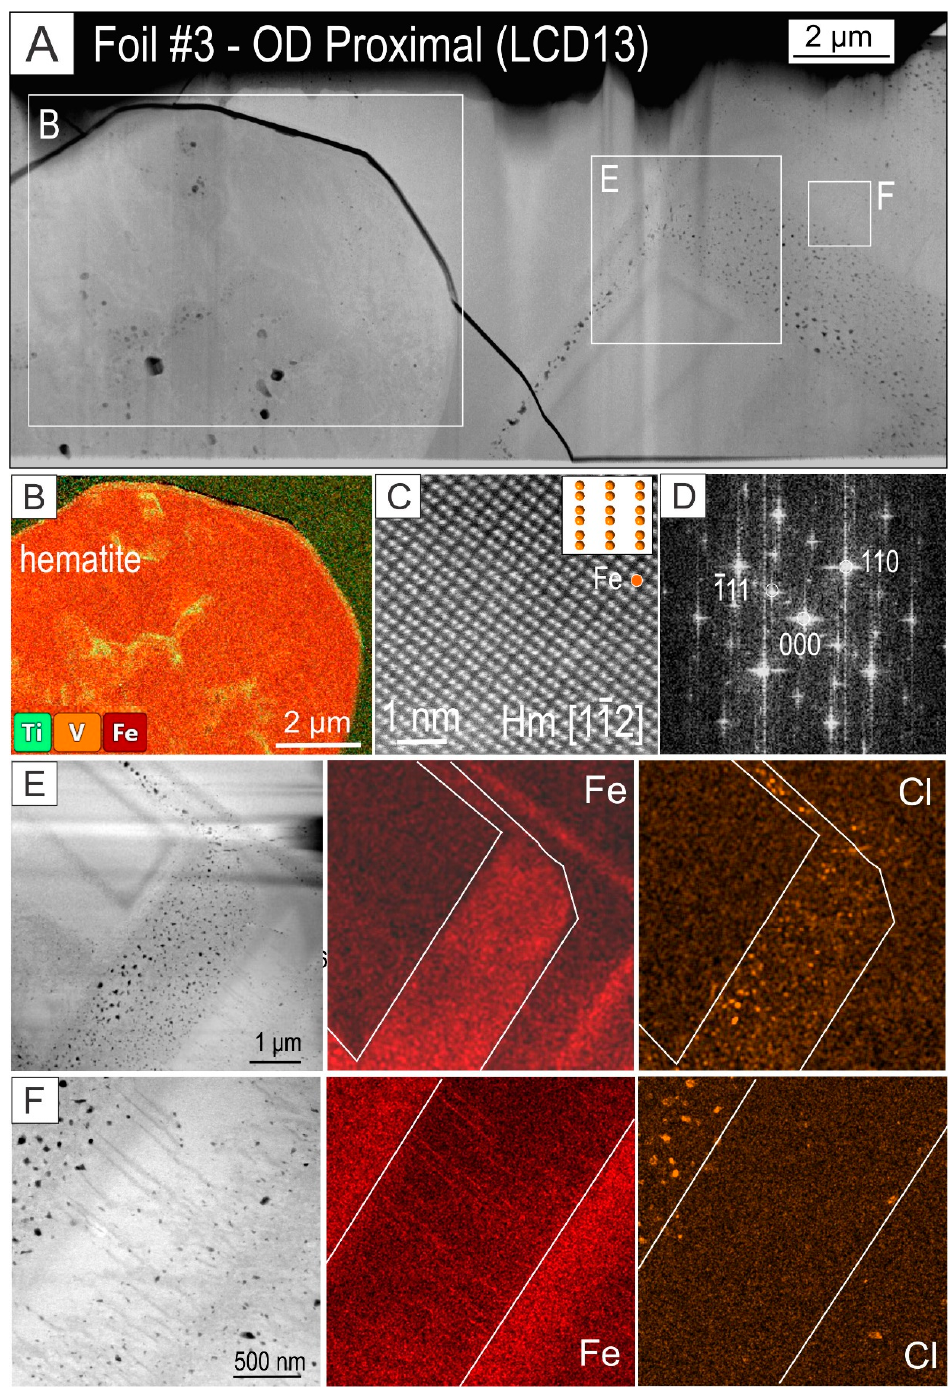
Figure 9. Trace element distributions in OD proximal zircon (Foil #3). ( A ) HAADF STEM image showing oscillatory banding, mottled textures, and an inclusion of hematite in zircon. High field strength element (HFSE) enrichment in hematite shown on the EDS STEM map in ( B ). Identification of hematite from the atomic-scale resolution image in ( C ) and Fast Fourier Transform (FFT) in ( D ) as marked. ( E , F ) HAADF STEM images and EDS STEM maps obtained from areas as marked on ( A ) (rotated 90 degrees clockwise) showing Fe and Cl enrichment throughout the mottled bands. Note the irregular distribution of Cl relative to Fe in both ( E ) and ( F ). Importantly, the Fe map in ( F ) shows Fe-rich veinlets crosscutting brighter bands.